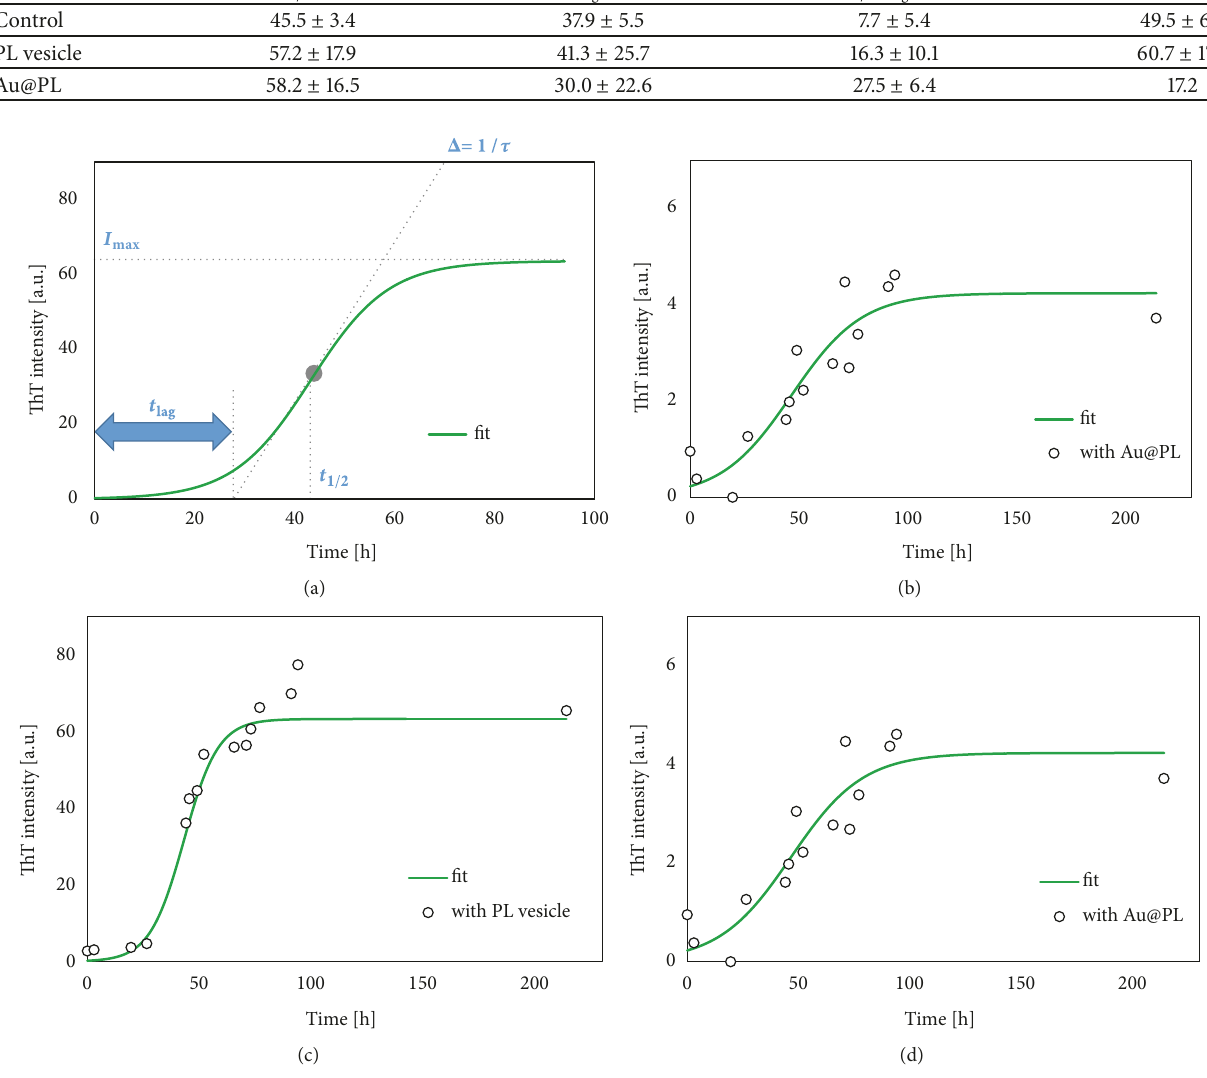
Figure 3: Time courseof ThT fluorescenceduring A 𝛽 fibrillation, and sigmoidal fitting for kinetics. (a)outline,(b)control, (c)with PL vesicle, and (d) with